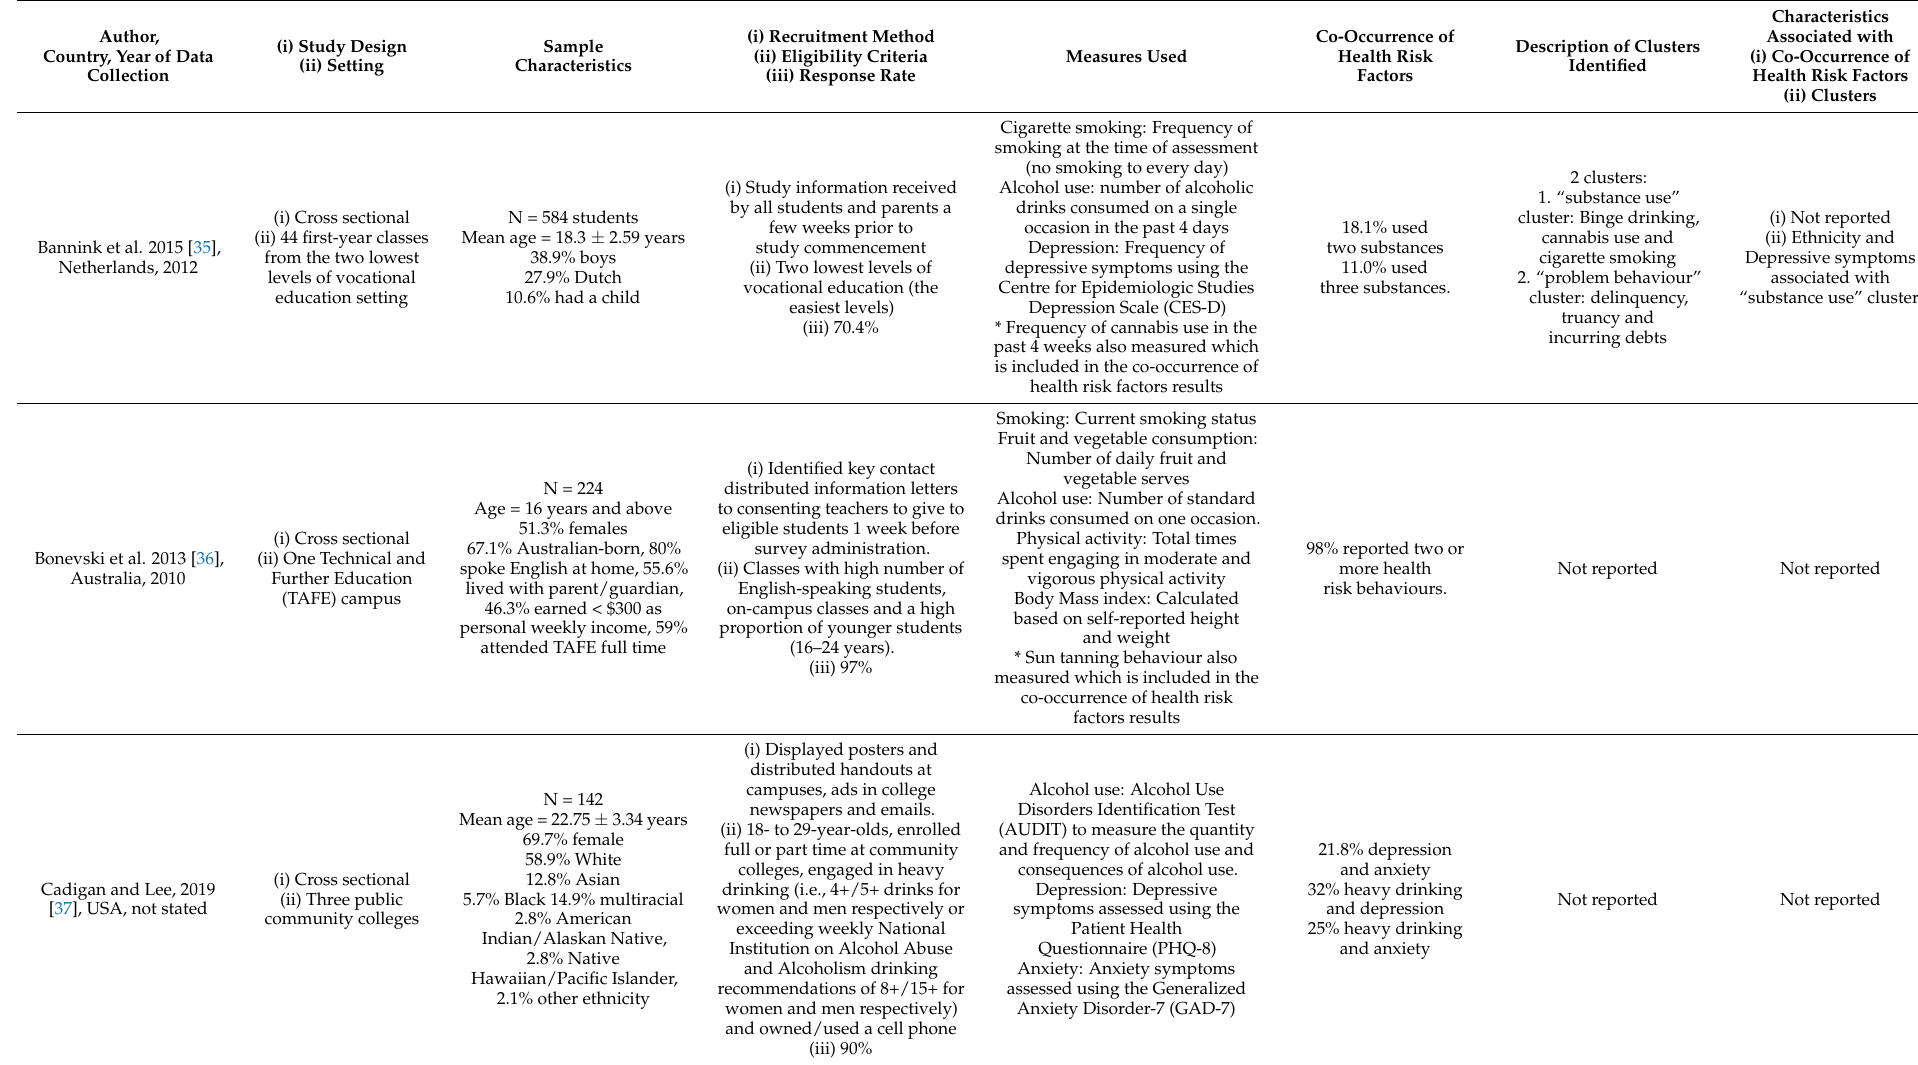
Table 2. Characteristics of studies examining the co-occurrence and clustering of health risk